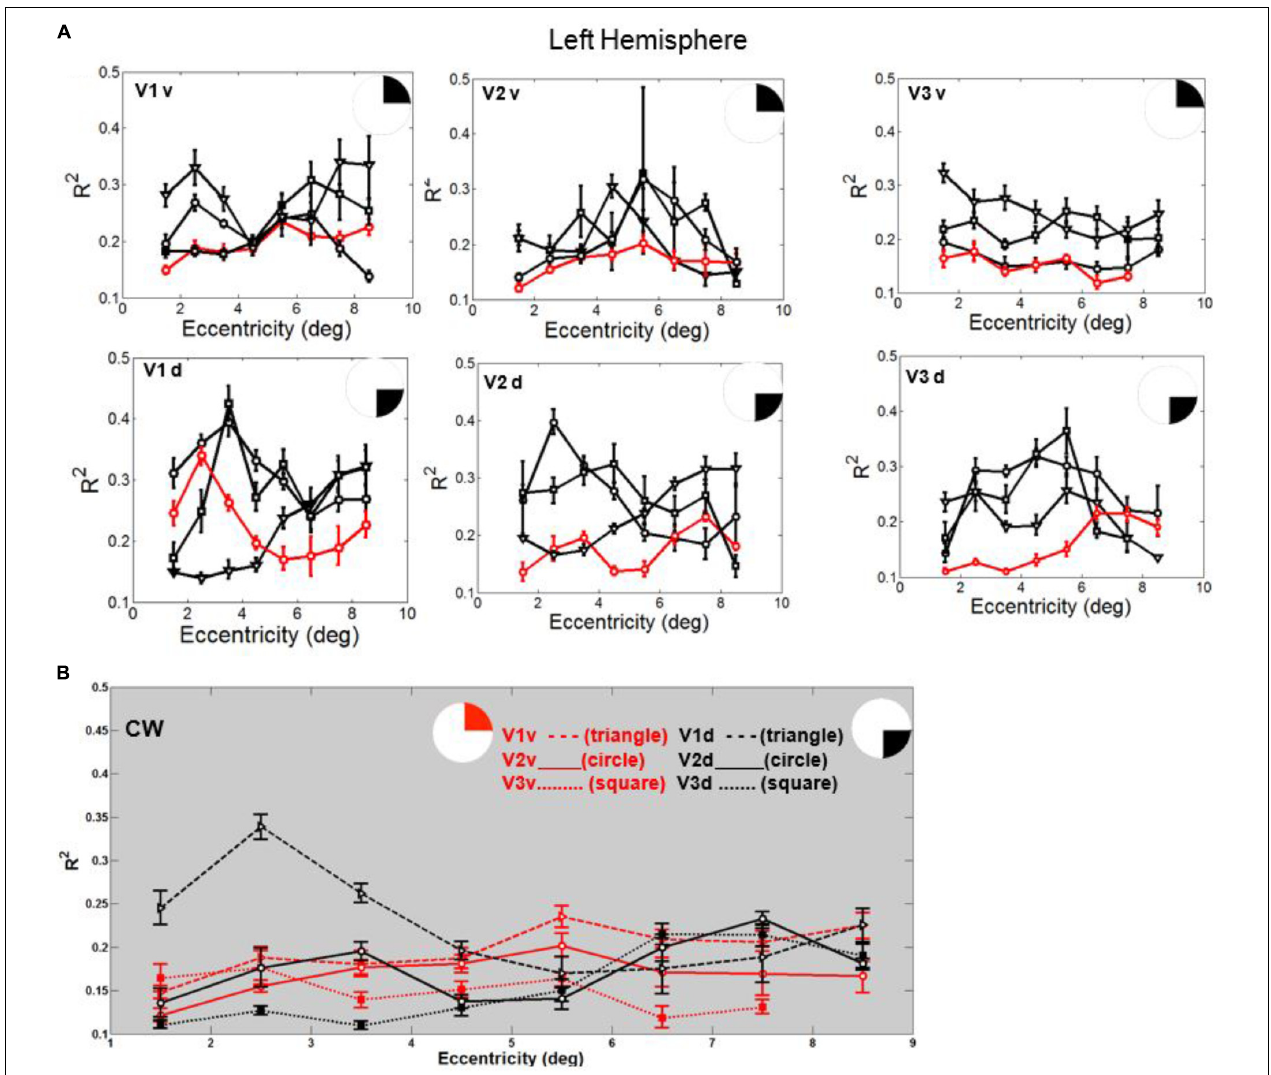
FIGURE 6 | (A) Goodness of fit (R 2 ) plotted against eccentricity for the ventral and dorsal early visual areas. Red color corresponds to CW, black color, to the three controls. Symbols denote the mean in each eccentricity band. Error bars denote 1 standard error of the mean. (B) CW’s data: Goodness of fit (R 2 ) plotted against eccentricity for the ventral (red) and dorsal (black) early visual